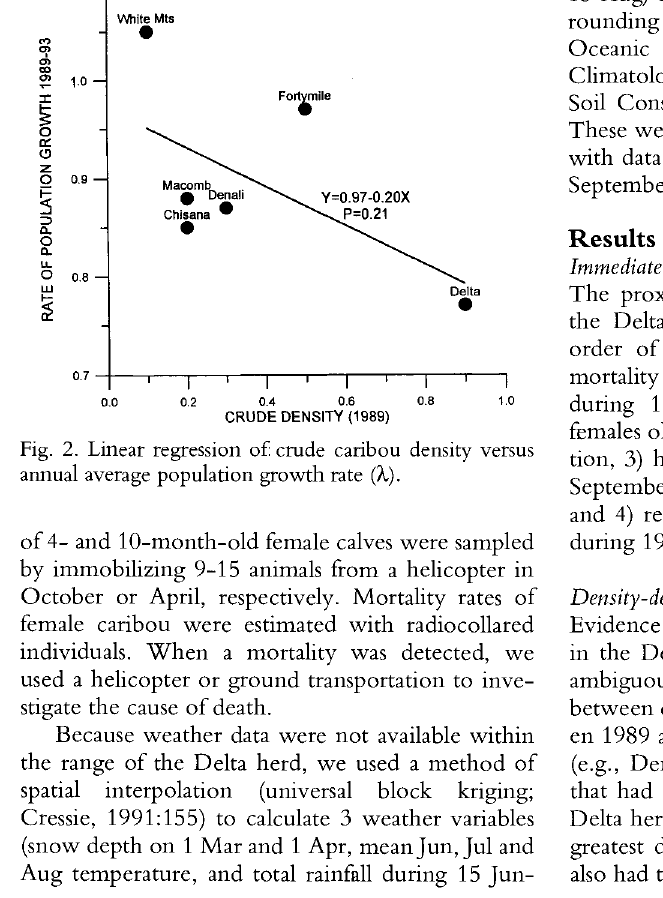
Table 3. Recruitment (fall calflOO cow ratio) in 7 Interior Alaska caribou herds from 1980 to 1993. Herd calf: 100 cow ratio in